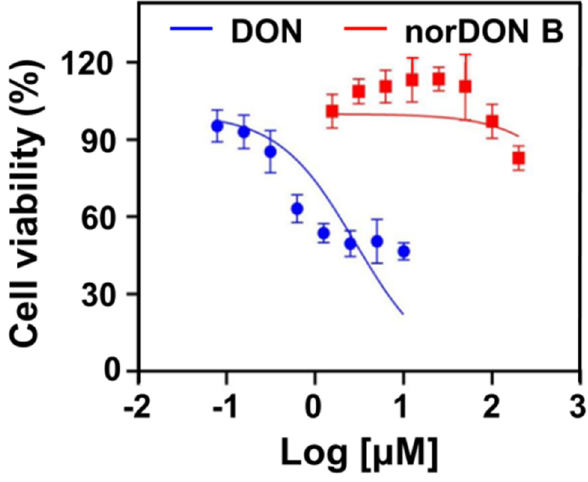
Figure 6. Cytotoxicity evaluation of the DON (blue) and norDON B (red).